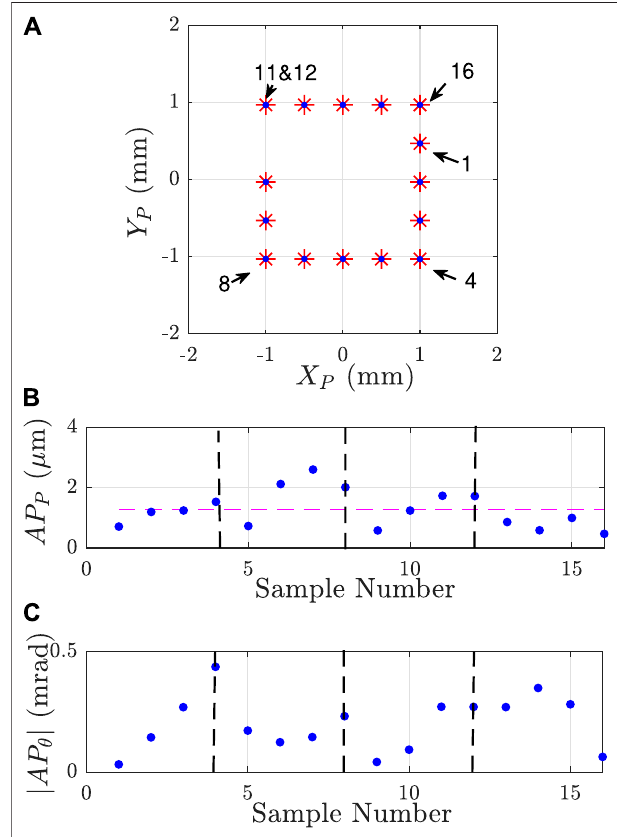
FIGURE 11 | Result of the robot position control for a square trajectory (A) commanded poses (in red) and attained by the robot (in blue) (B) position and (C) orientation accuracies obtained for the different poses. The horizontal dashed-line is the mean value of the positioning accuracy which is 1.27 µm. The black dashed-lines are characteristic points (numbered points) on the trajectories (corners of the square) which correspond to points where the AP P or AP θ monotony change.